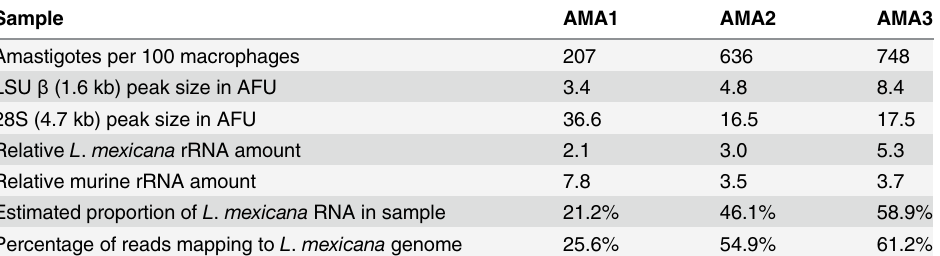
Gene models based on RNA-seq data predict 936 novel genes Assignment of SLAS and PAS to genes was initially performed using version 6.0 of the L . mexi- cana genome. We found that in the majority of cases (6,796 annotated protein coding genes) there was good correspondence between an annotated coding sequence (CDS), RNA-seq read coverage and positions of SLAS and PAS. We did however find many loci bounded by SLAS at Table 1. Estimate of L . mexicana RNA in mixed RNA samples from infected BMDMs. Sample AMA1 AMA2 AMA3 Amastigotes per 100 macrophages 207 636 748 LSU β (1.6 kb) peak size in AFU Relative L . mexicana rRNA amount Relative murine rRNA amount Estimated proportion of L . mexicana RNA in sample 21.2% 46.1% 58.9% Percentage of reads mapping to L . mexicana genome 25.6% 54.9% 61.2% Peak sizes of the LSU β and 28S rRNA subunits were measured in arbitrary fl uorescence units (AFU) on an Agilent Bioanalyzer. To estimate the proportion of L . mexicana RNA in the sample, AFU were divided by length of the corresponding rRNA to determine the relative amounts of leishmanial and murine rRNAs. The number of amastigotes per 100 macrophages was determined by light